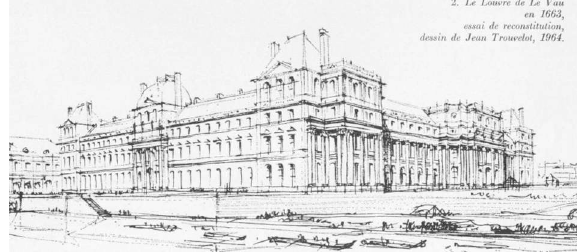
Figure 3: Trouvelot’s Sketch Reconstruction of Le Vau’s 1663